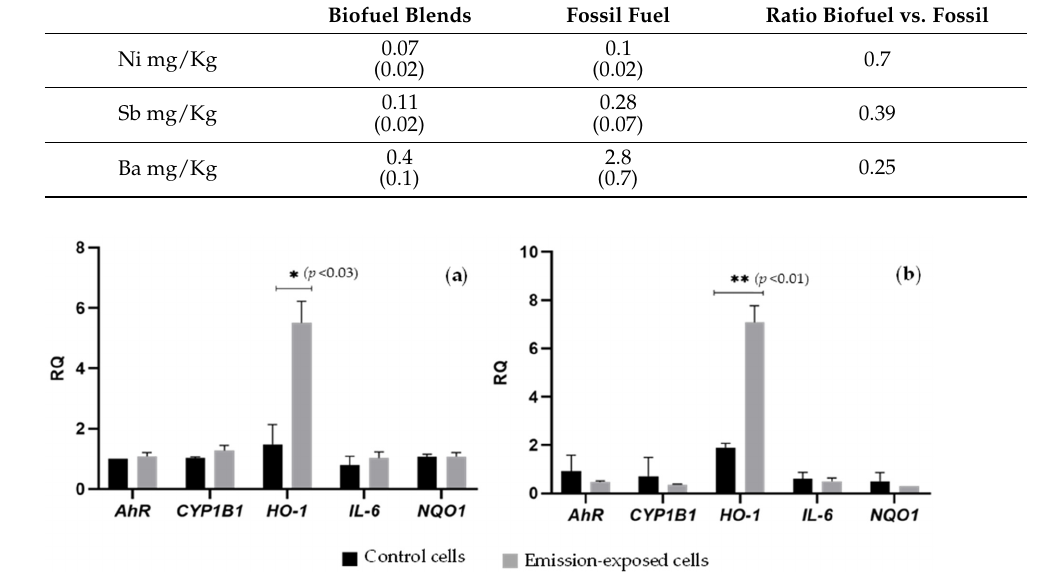
Figure A1. Gene expression of selected genes during the two exposures to fossil fuel emissions. Fossil I ( a ) and fossil II ( b ) emissions caused similar gene expression variation. All the other genes were not modified.